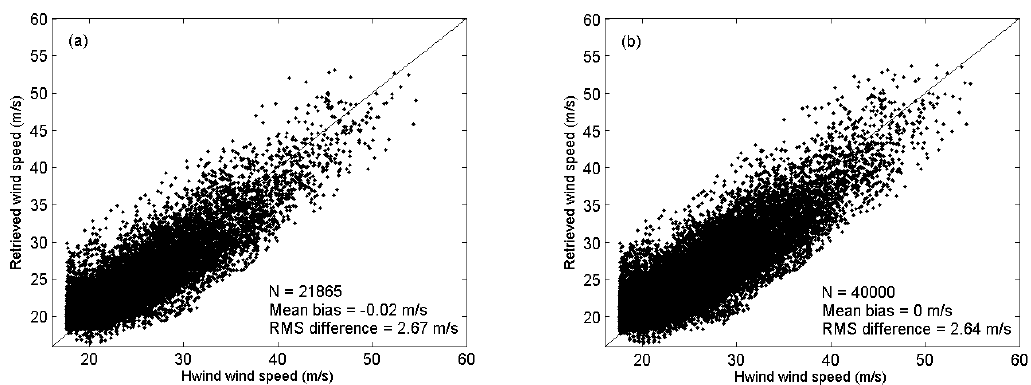
Figure 5. Comparisons between H*wind analysis data and the retrieved wind speeds: ( a ) testing results; and ( b ) validation results.